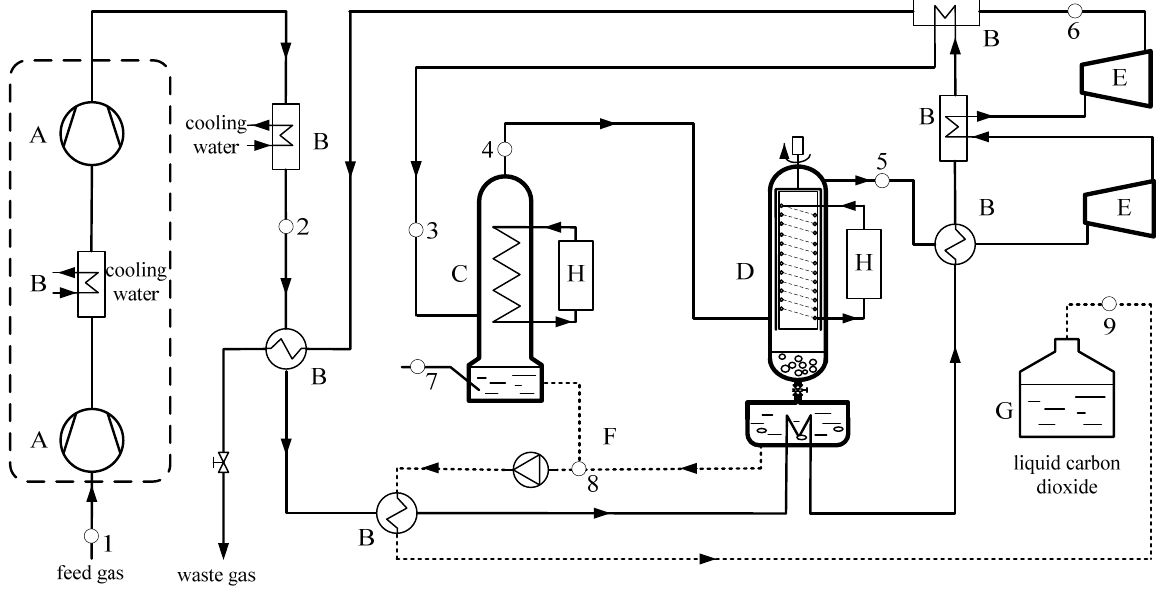
Figure 1. Schematic diagram of liquefaction combined with desublimation CO 2 capture